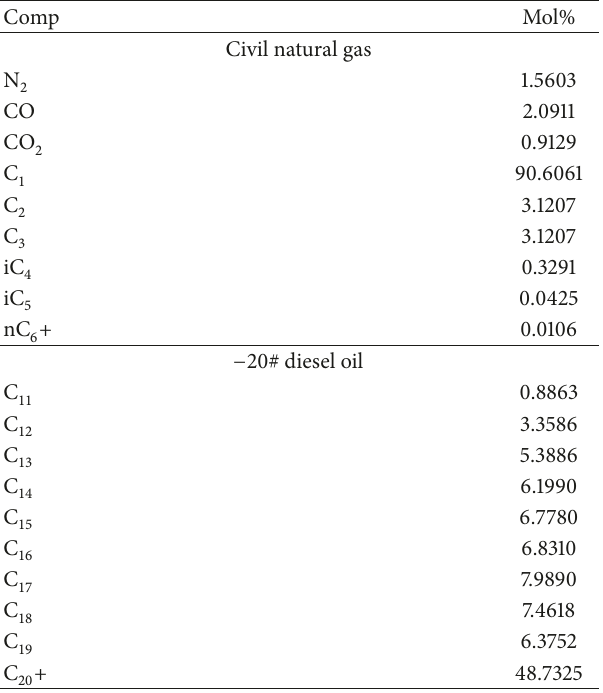
Table 1: Compositions of civil natural gas and − 20# diesel oil.